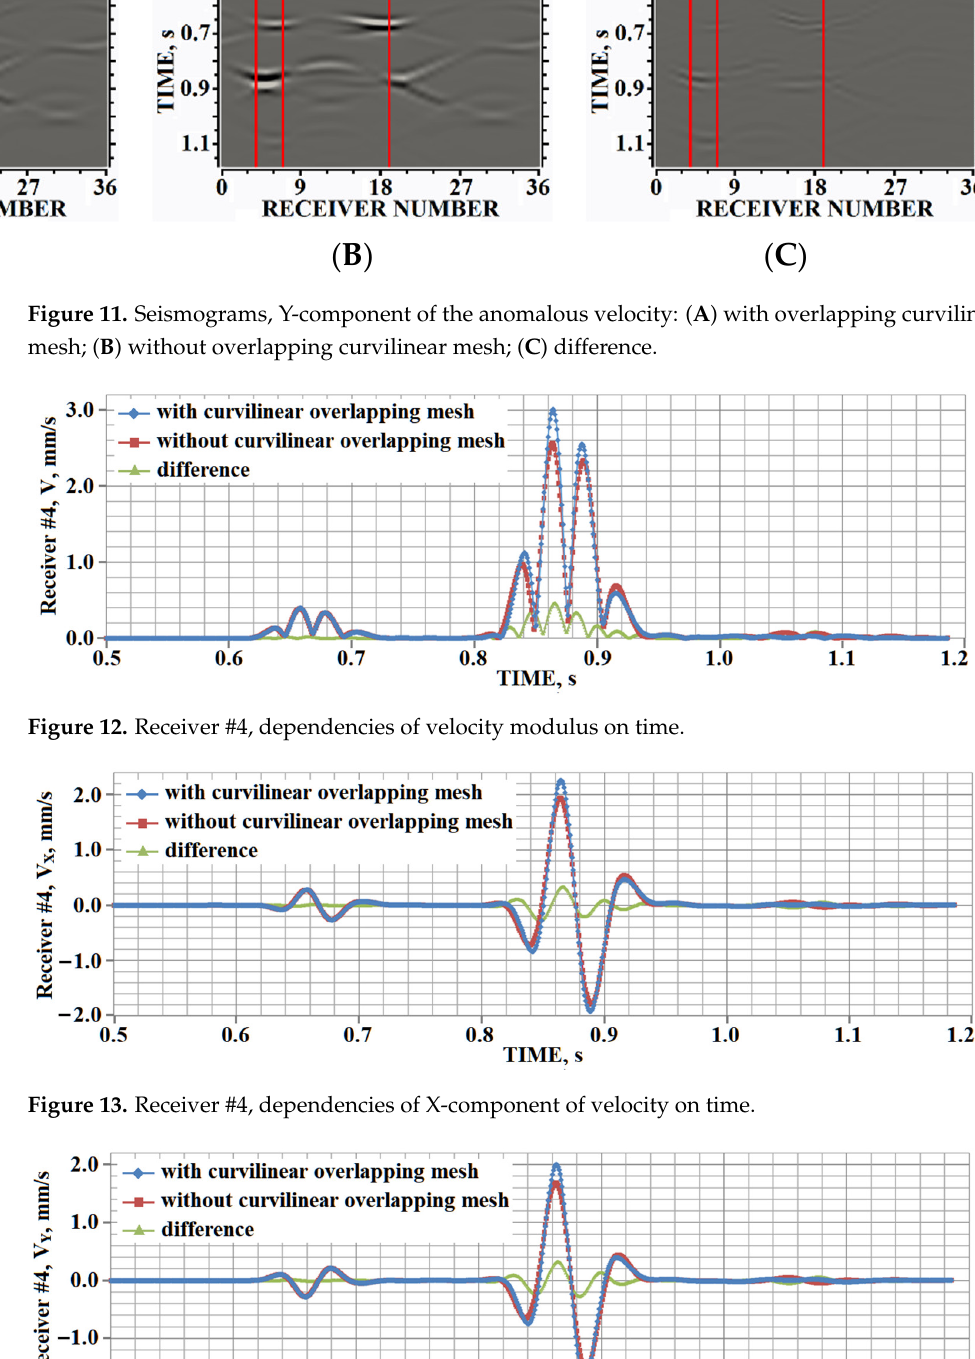
Figure 13. Receiver #4, dependencies of X-component of velocity on time.